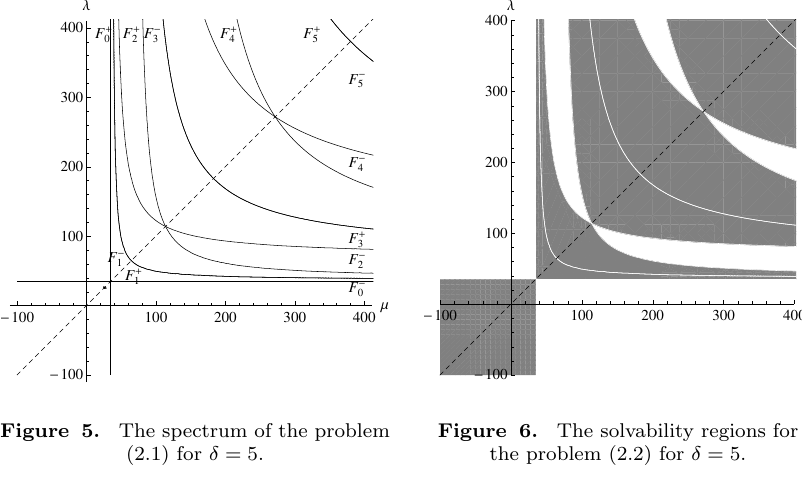
Figure 6. The solvability regions for the problem (2.2) for δ =